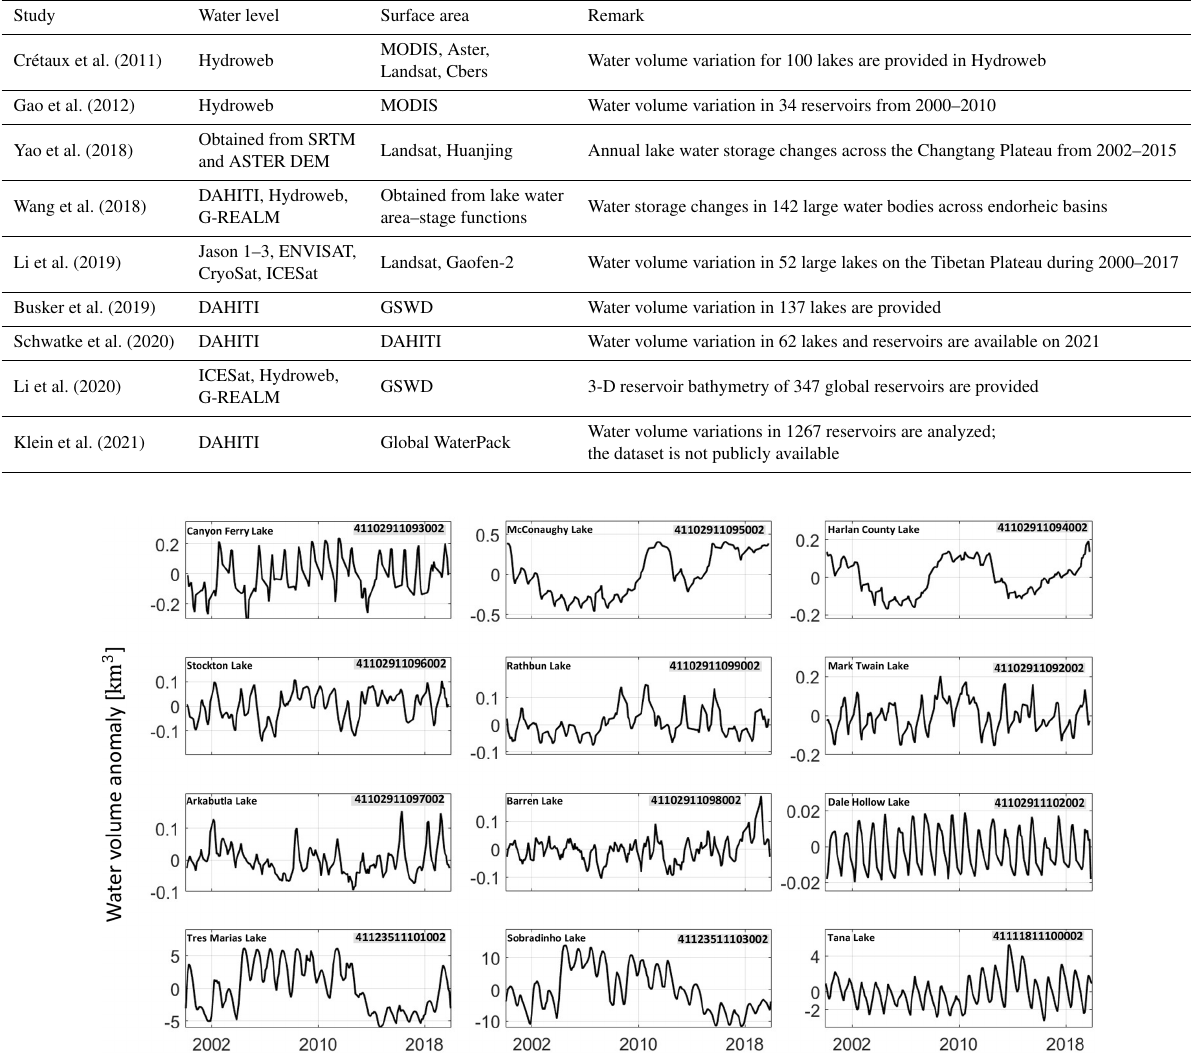
Figure 6. Time series of water volume change in selected lakes and reservoirs. The location of these lakes can be found in Figs. 2 and